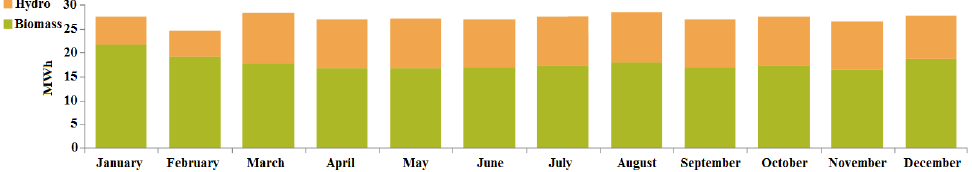
Figure 14. Total cash-flow study for case I (Ba/Bi/H). 6.2. Case II: Ba/Bi/S In case II, the renewable resources allocated for fulfilling the necessary load re- quirements are: biomass (Bi) and solar-PV (S) backed up by a battery (Ba). The simulation model for the proposed combination is shown as case II in Figure 9. In this case, the op- timized NPC value was found to be USD 807,292.10, along with the COE being 0.1607 USD/kWh and cost of operation (OC) being 35,582.13 USD/year. The autonomous re- newable-based IES sizes are: solar-PV — 200 kW, biomass-based generator — 50 kW and battery — 404 kWh. The demand for satisfying the load is computed to be 314,013 kWh/year and the energy generated from the proposed configuration is 393,071 kWh/year, among which the solar-PV generates 250,497 kWh/year (i.e., 63.7%) and the biomass-based generator generates 142,573 kWh/year (i.e., 36.3%). The percentage of en-